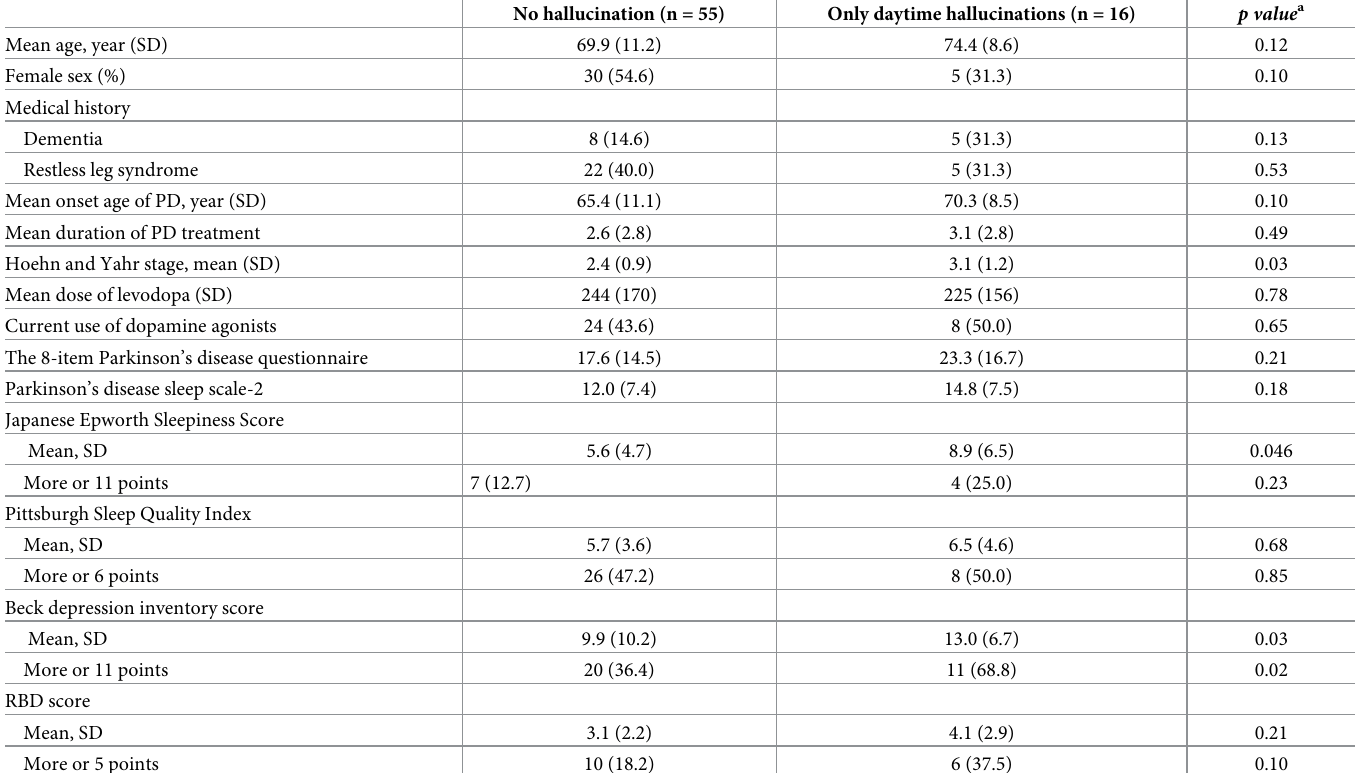
Table 5. Demographic and clinical features of Parkinson’s disease patients with only daytime hallucinations and without any hallucinations.